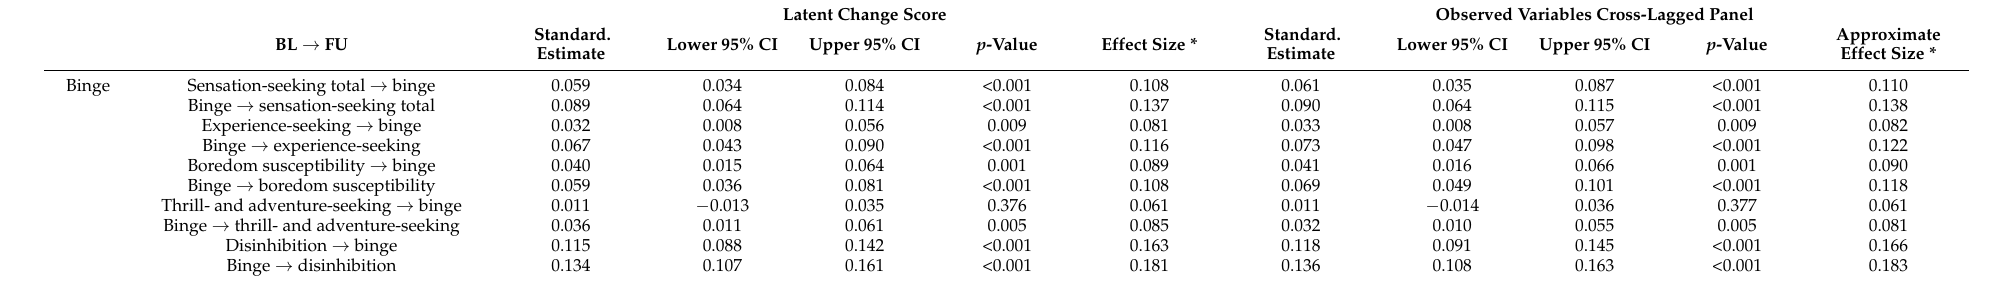
Table 5. Standardized path coefficients of cross-lagged models of binge drinking with only observed (right) and observed and latent change score variables (left),